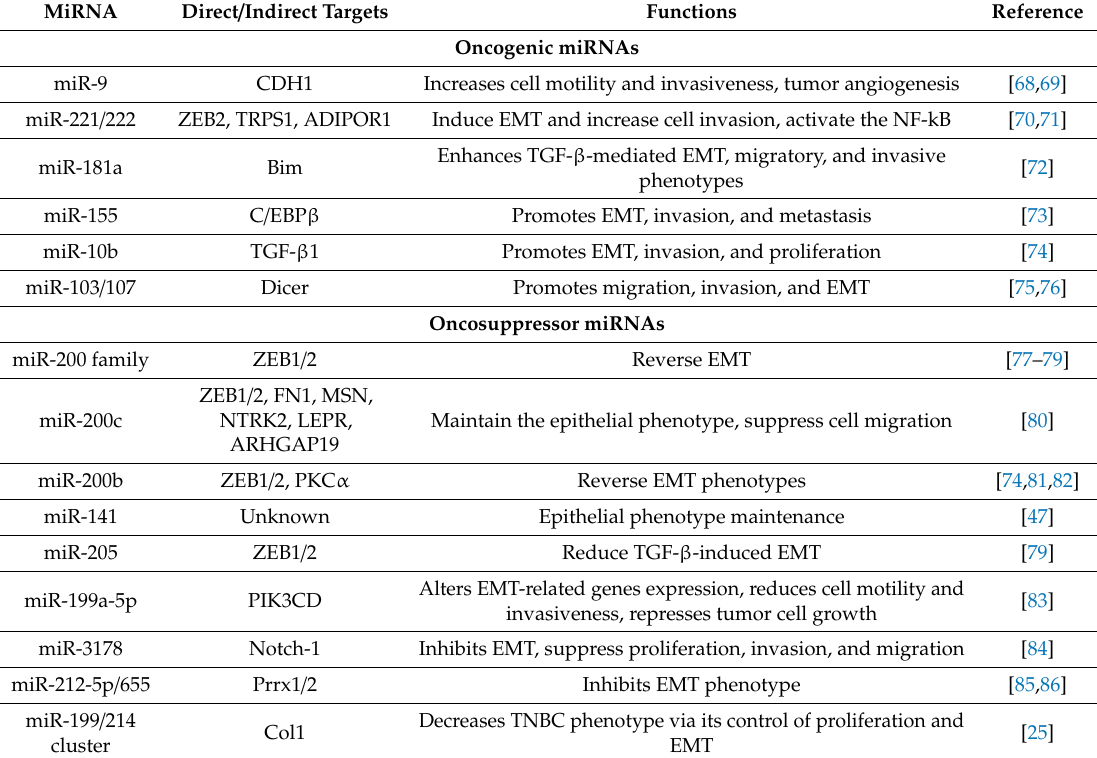
Table 3. MiRNAs associated with EMT in